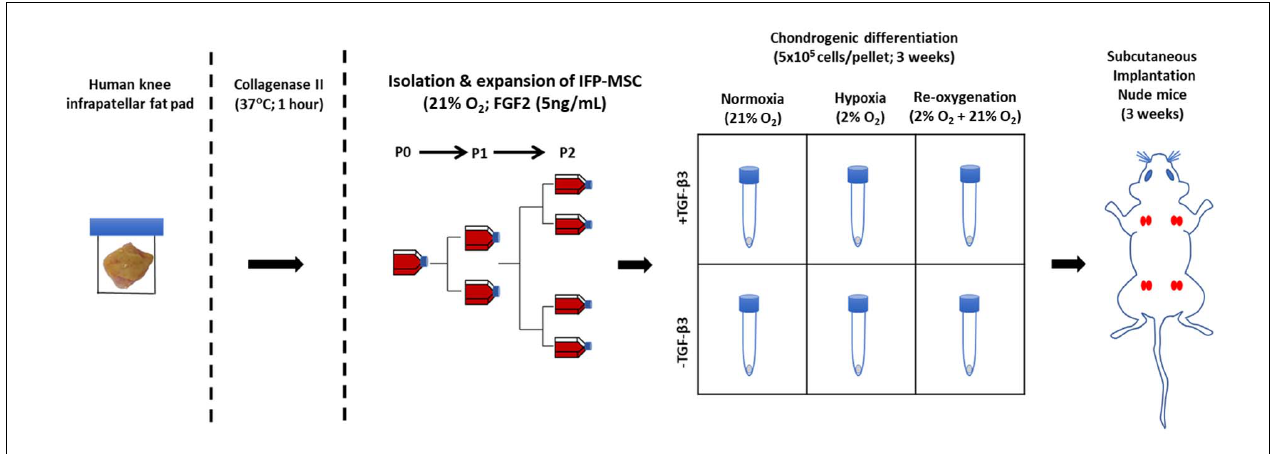
FIGURE 2 | Experimental setup for isolation, expansion, in vitro chondrogenesis, and in vivo implantation of infrapatellar fat pad-derived MSC (IFP-MSC) in a pellet culture (5 × 10 5 cells/pellet). Subcutaneous implantation of four groups of cultured pellets in duplicates (same donor) in the back of a male nude mice for 21 days; each group from the same donor was cultured in a different manner than the others ( ± TGF β 3 supplementation and HYP/NRX/Re-Ox).